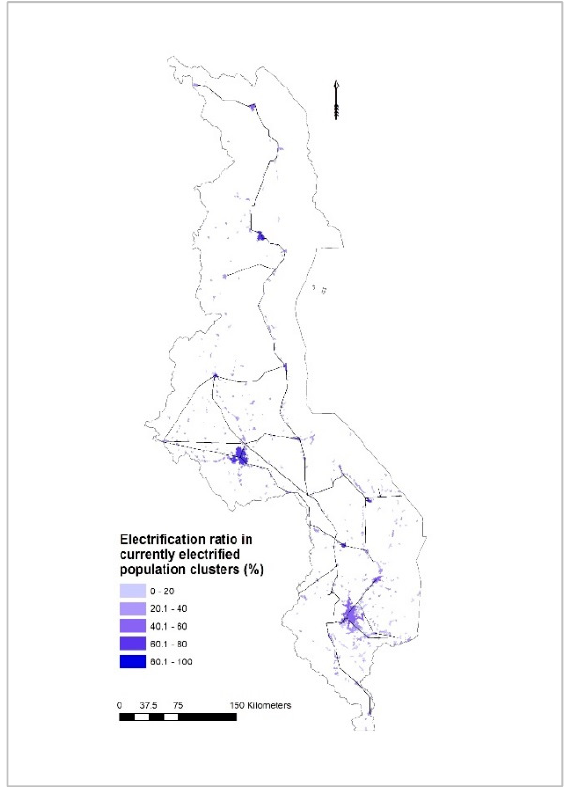
Figure 4. Distribution of settlements that indicate current access to electricity in Malawi. The multi- criteria evaluation yielded 16 urban and 798 rural electrified settlements with average electrification rates of 46.3% and 21.2%